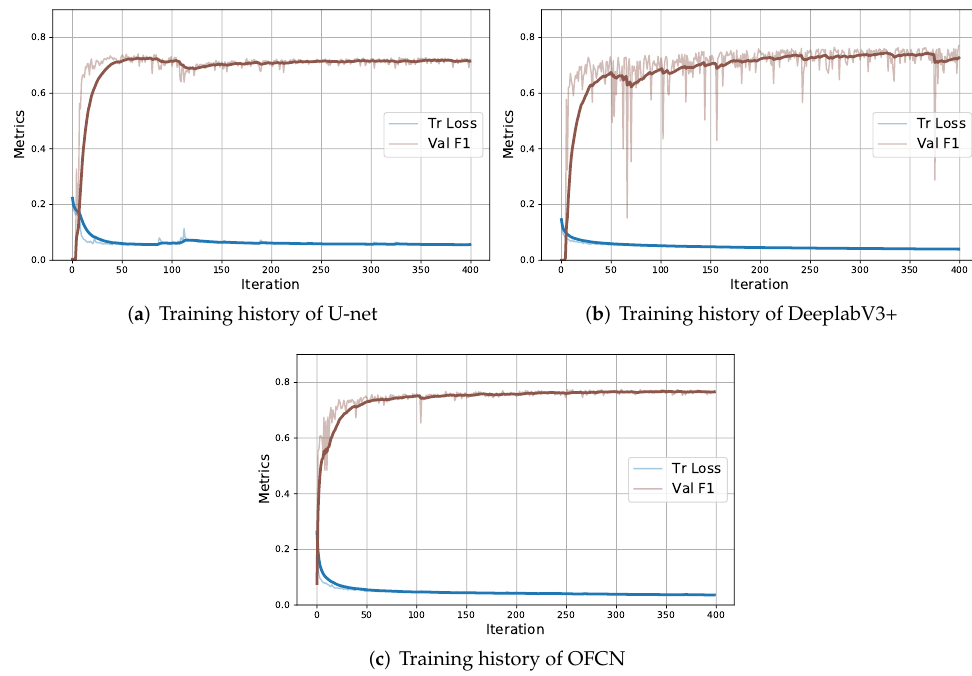
Figure A3. Evolution of training loss and F1 score on validation across the 400 training epochs on dataset D 1 . Bold line indicates a running average with window of size